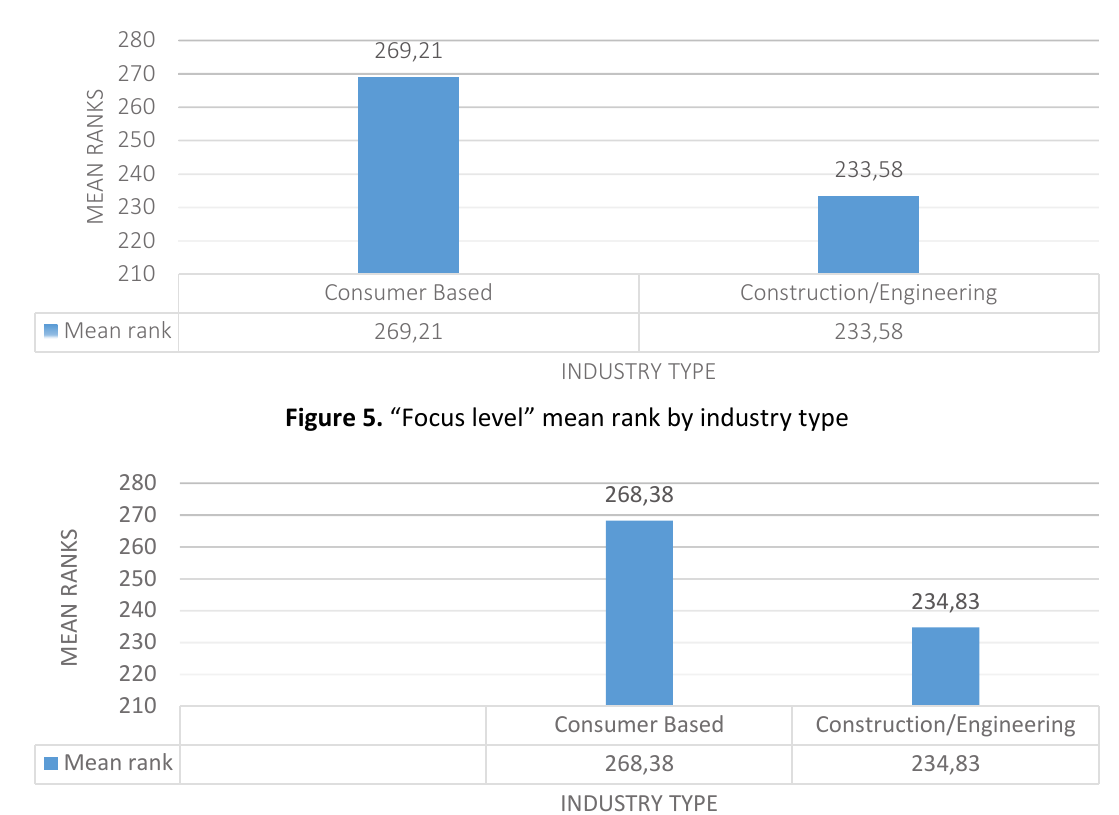
Figure 6. “Level of control” mean rank by industry